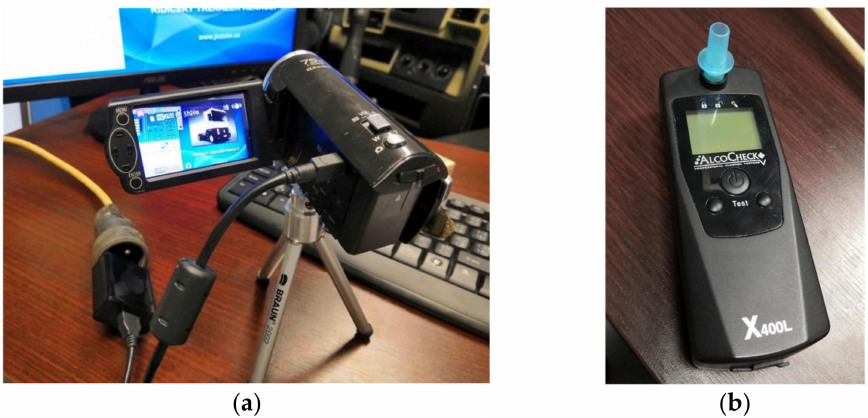
Figure 2. Other equipment: ( a ) External video camera for recording; ( b ) AlcoCheck X400L. Source: Processed by